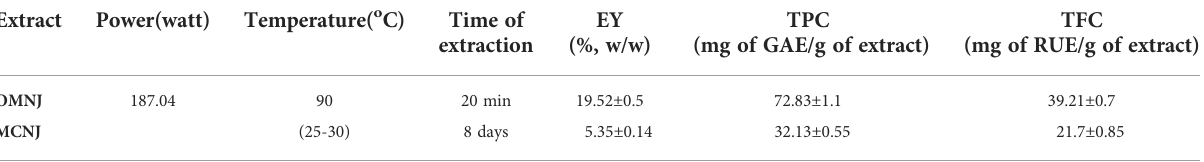
TABLE 4 A comparative assessment for the various extracts of NJ for EY, TPC and TFC. Extract